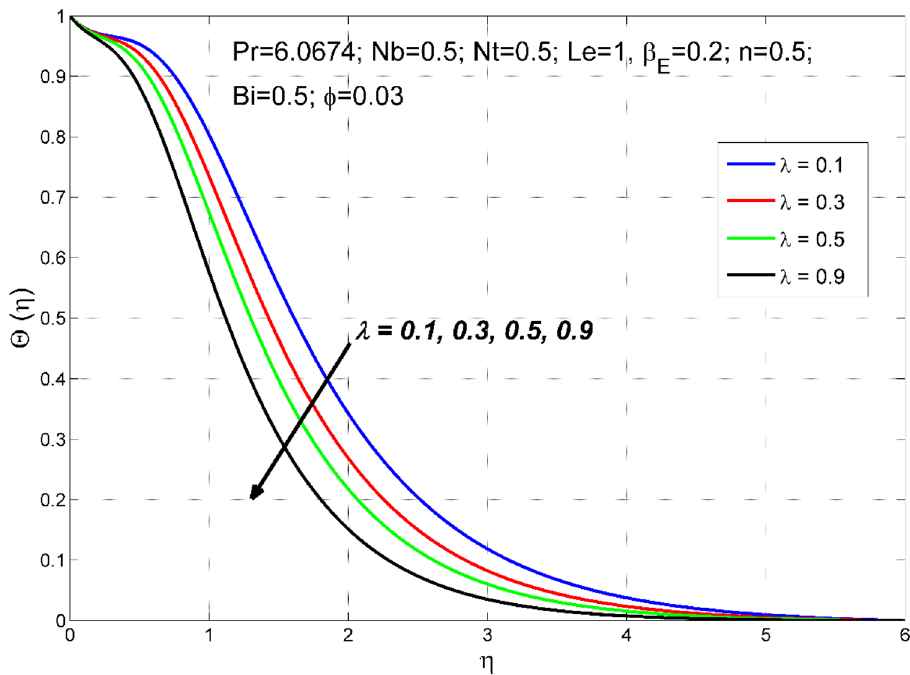
Figure 5. The nanoparticles volume fraction distribution �(η) behavior for the variation of the stretching ratio (cid:31) .